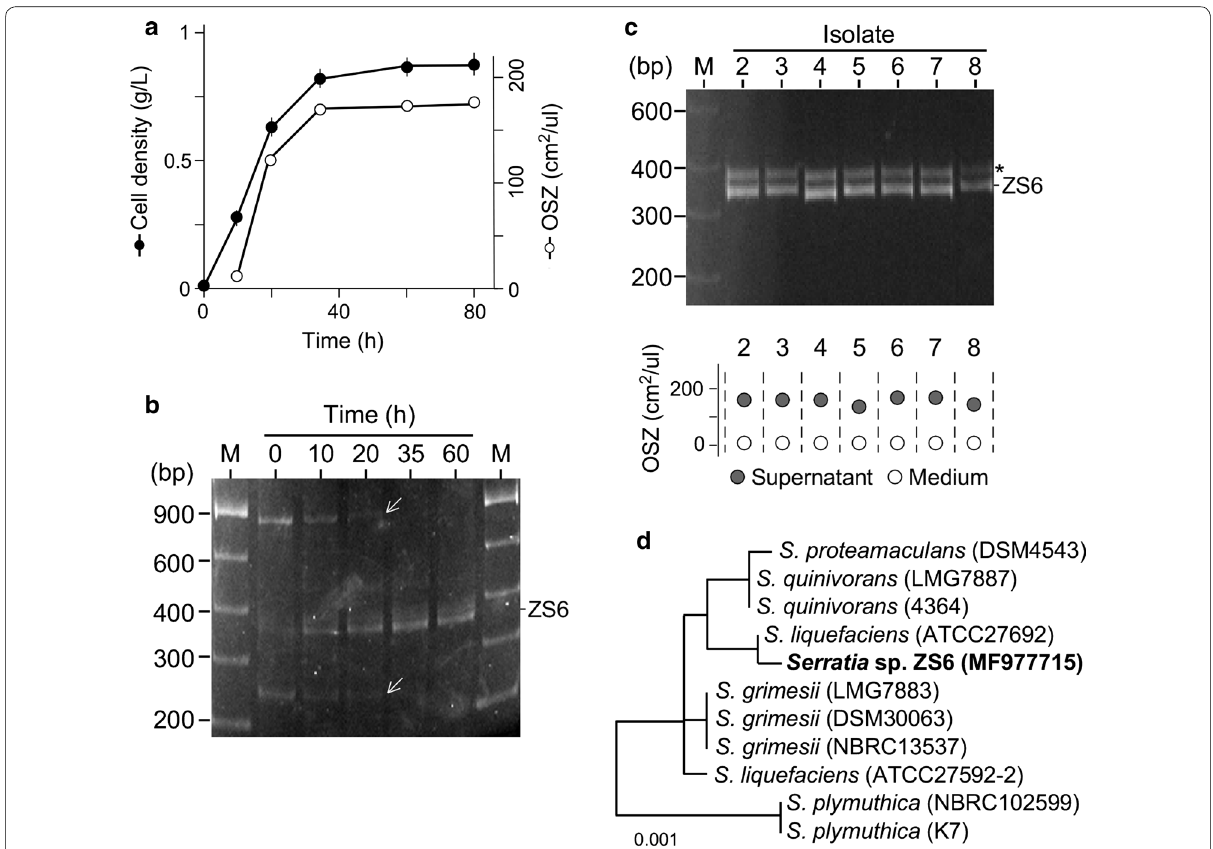
Fig. 1 Enrichment and isolation of the oil emulsifying microbe in medium with olive oil as sole carbon source. a Cell growth is associated with production of biosurfactant activity. X- and Y-axes indicate time (h) and cell density (g L − 1 , solid circle) or oil spreading zone (OSZ, cm 2 µL − 1 , open circle). b Microbial populations enriched in cultures with olive oil as sole carbon source. mT-RFLP analysis shows the level changes of three major populations (or fragments), two of which decrease (see arrows) and one increase (see ZS6). c mT-RFLP pattern of individual isolates. A non-specific fragment (see asterisk) is found to be associated with 16 rDNA PCR fragment in ZS6. Biosurfactant activity of individual isolates is shown in the bottom panel. d The phylogenetic tree analysis is based on 16S rDNA sequences whose GenBank accession number (ZS6, MF977715) is shown in parentheses. ZS6 isolate belongs to the member of Serratia